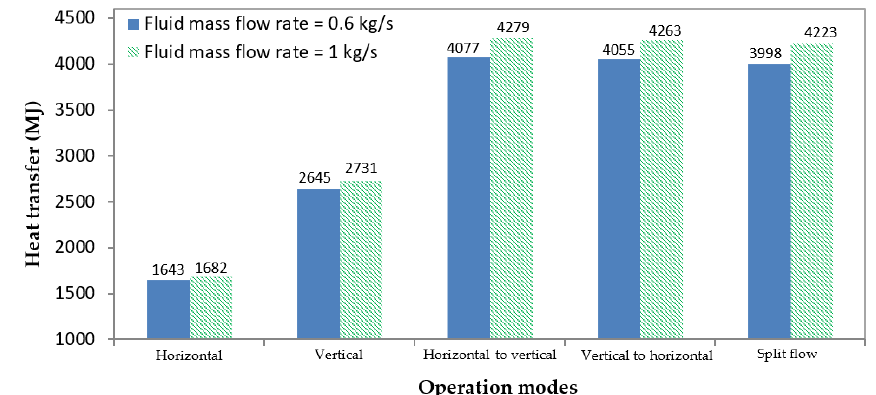
Figure 17. Profile of fluid temperature of the horizontal, vertical, and the horizontal to vertical modes with variations in the fluid mass flow rates, in Adelaide.